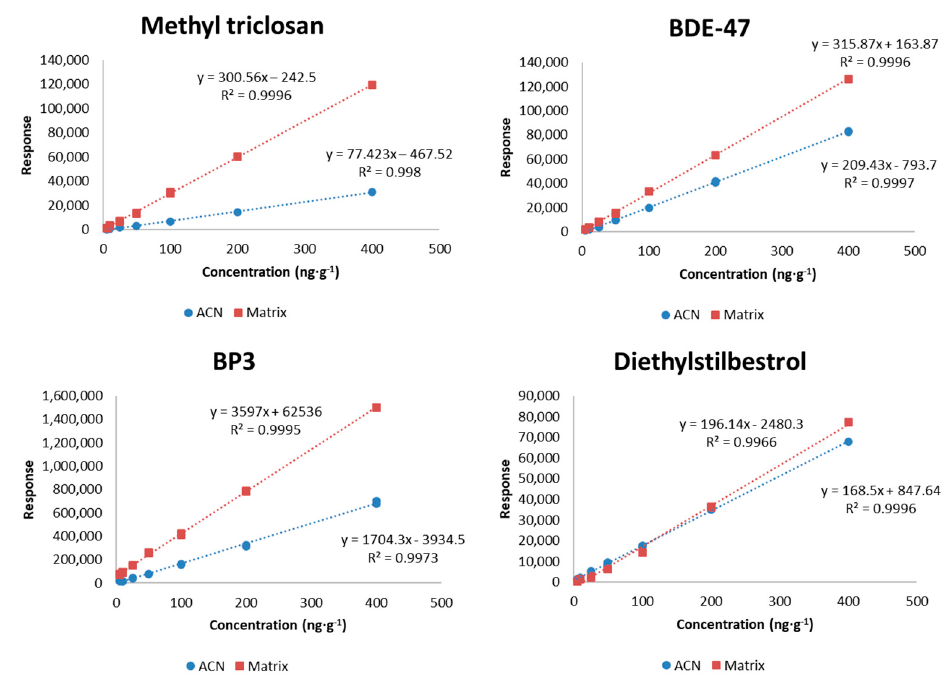
Figure 3. Comparison of seven-point calibration curves of methyl triclosan, BDE-47, BP3 and diethylstilbestrol, obtained by injection of standards in neat solvent ACN and spiked spirulina extracts, ranging from 5 to 400 ng·g − 1 .